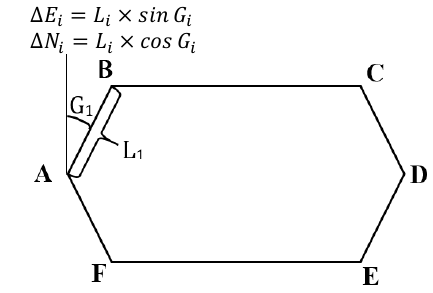
Figure 1. A closed traverse network. The azimuth angle (G 1 ) and the length (L 1 ) of AB are specified.